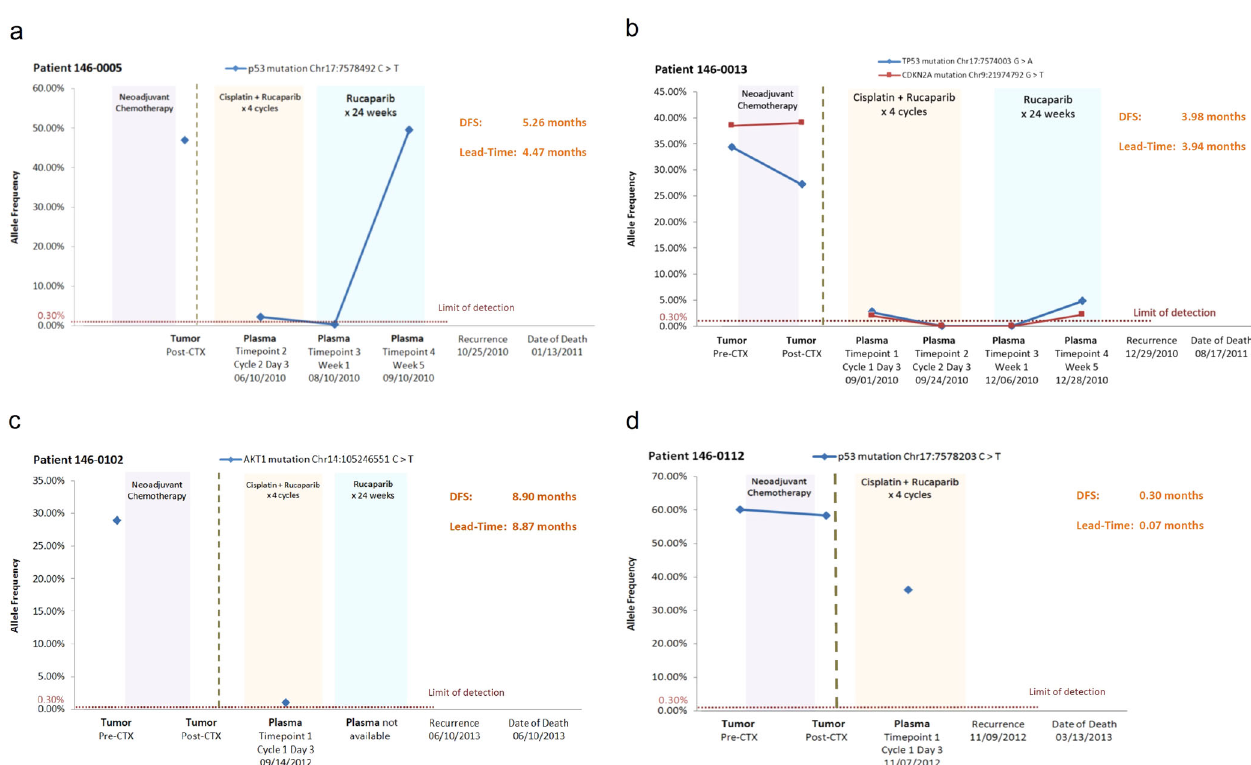
Fig. 4 Longitudinal allele frequency tracking of ctDNA mutations. Somatic mutations were fi rst identi fi ed in the primary tumor. These mutations were then searched for in matched plasma samples. ctDNA mutations were identi fi ed in four patients at varying allele frequencies. From patient 146-0005(a) and patient 146-0013(b), the increasing allele frequency of ctDNA was observed before clinically recurrence was diagnosed. Patient 146-0102(c) and patient 146-0112(d) had only one timepoint plasma sample available, and we were able to detect the ctDNA before clinical recurrence as well. The lead-time range was 0.07 to 8.87 months